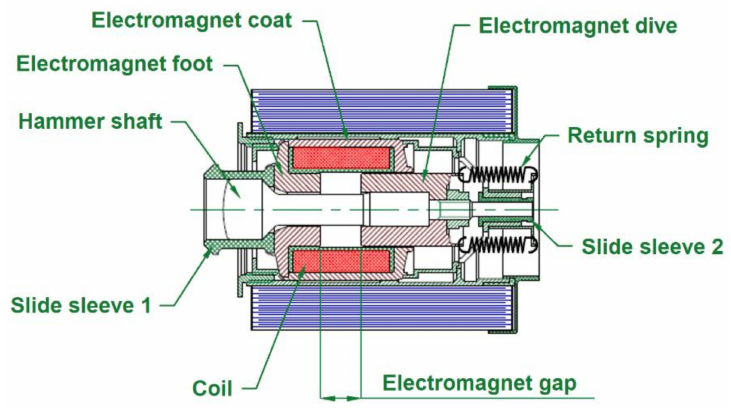
Figure 2. MUPUS and CHOMIK penetrator drive unit [6,7].